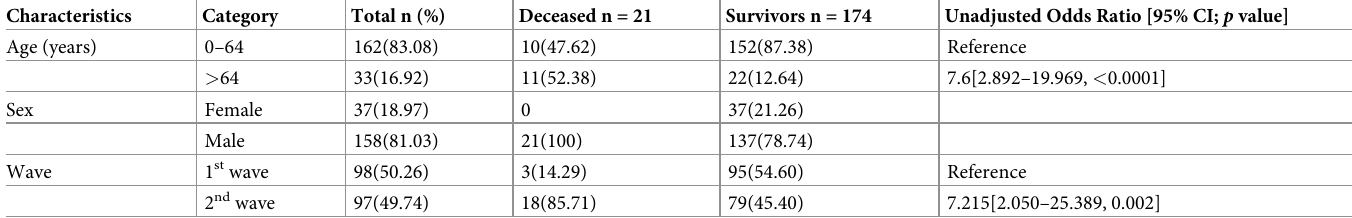
Table 1. Characteristics of study population and univariate analysis of mortality risk factors of COVID-19 patients (N = 195) at the Kwanar Dawaki isolation cen- ter, Kano, Nigeria.